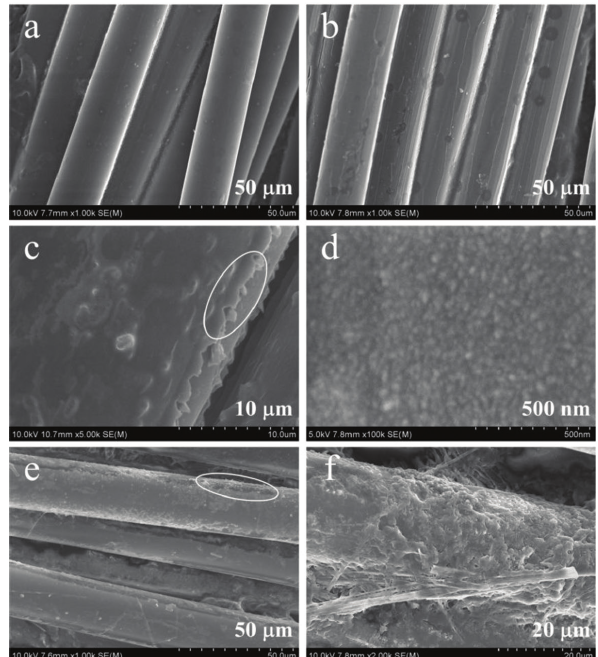
Figure 3: SEM images of PET (a), PET/ZnO (b-d) and PET/ZnO/TTCP (e,f) woven